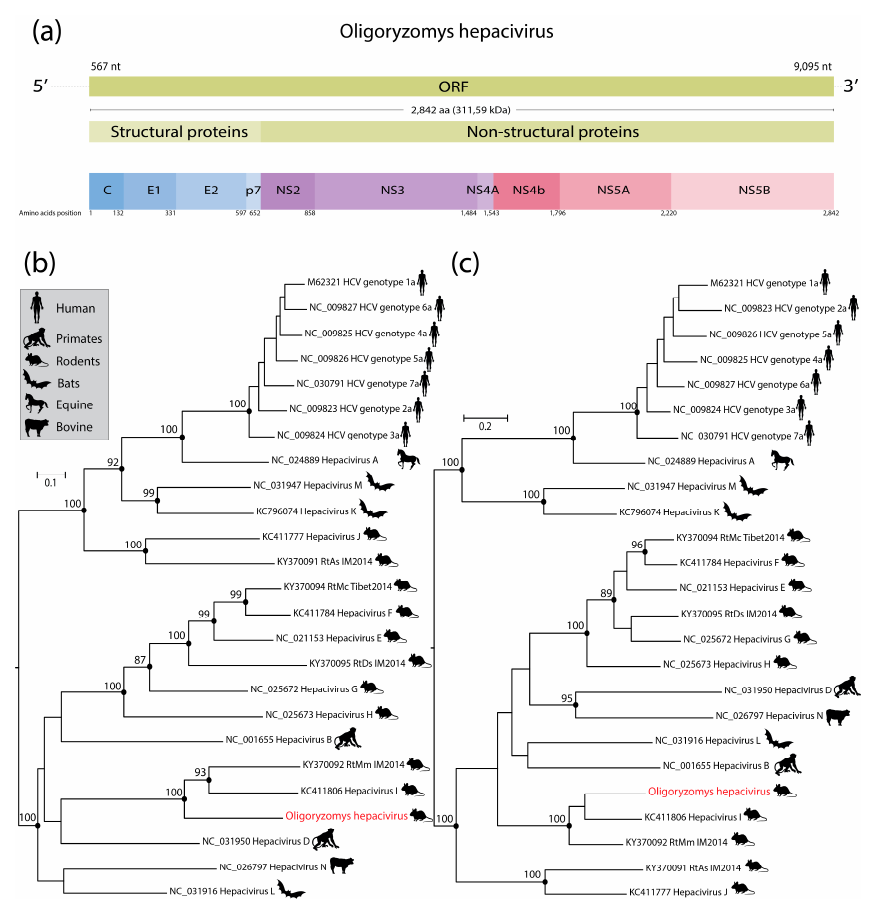
Figure 1. Putative genome organization of the nearly complete genome of Oligoryzomys hepacivirus (OHV) ( a ). Maximum likelihood phylogenetic trees showing the evolutionary relationships of OHV with representative members of the Hepacivirus genus in NS3 protease ( b ) and NS5 RdRp ( c ). Phylogenies were midpoint rooted for clarity. The scale bar indicates evolutionary distance in numbers of substitutions per amino acid site. Bootstrap values ( ≥ 85) of 1000 replicates are shown in main nodes. The OHV sequence generated in this study is highlighted in red color. HCV: Hepatitis C virus; RtAs: Rodent hepacvirus Allactaga sibirica; RtMC: Rodent hepacvirus Neodon clarkei; RtDs: Rodent hepacvirus Dipus sagittal; RtMm: Rodent hepacvirus Meriones